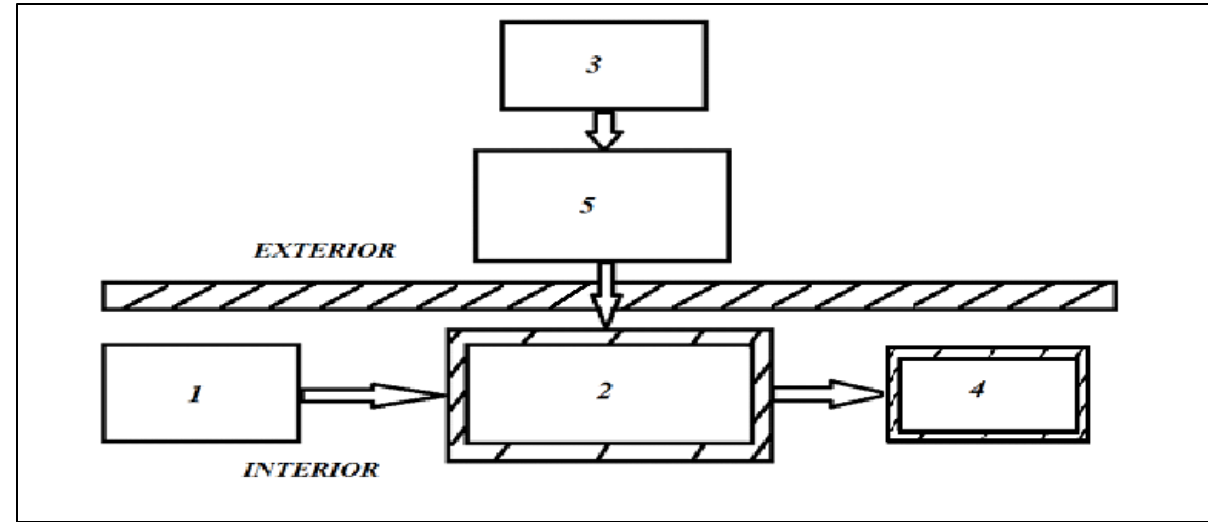
Figure 2. Structural and functional diagram of the refrigeration installation and the water accumulator for milk chilling in the capacitive cooler by using natural and artificial